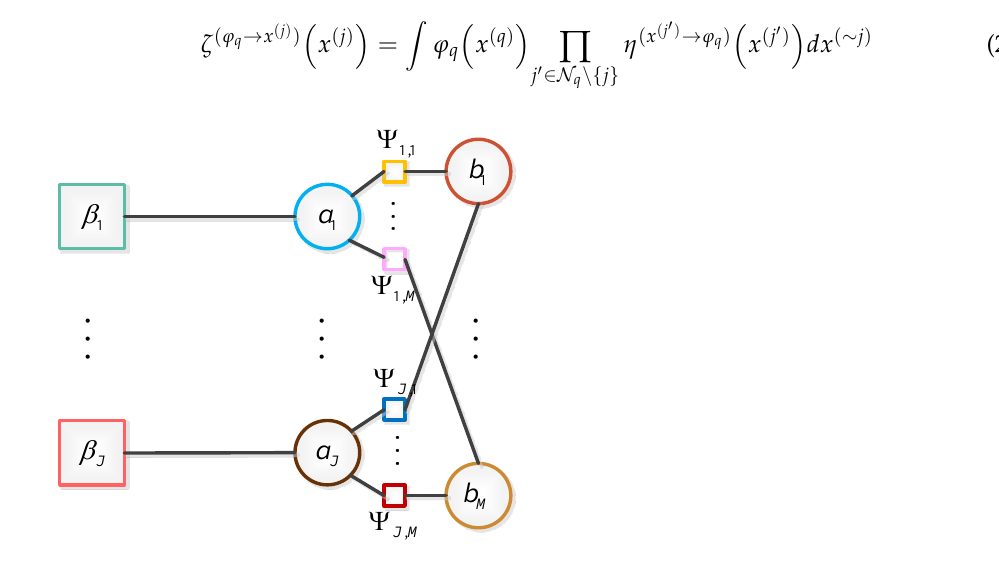
Figure 3. Factor graph representing the factorization (20) and (21).